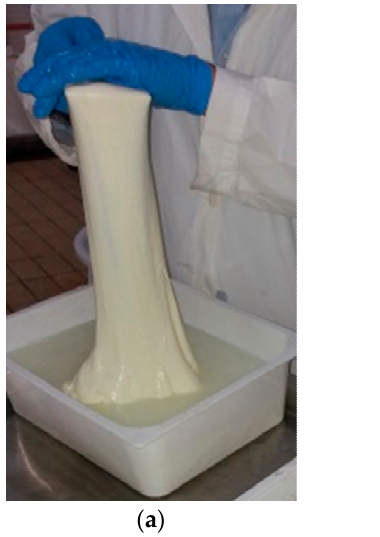
Figure 2. Stretching step of the acidified curds. ( a ) Control cheese production; ( b ) GPP-enriched cheese production.